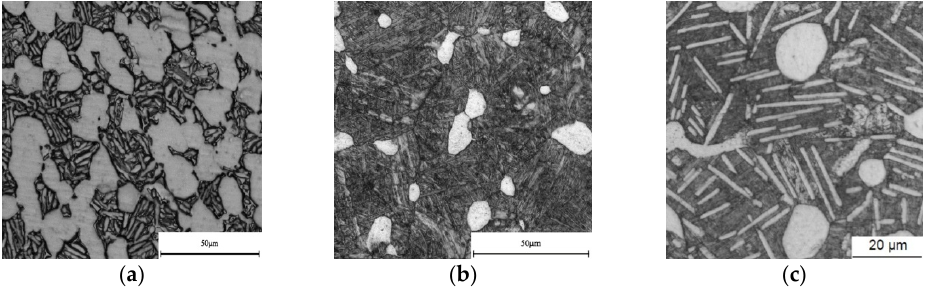
Figure 1. Optical microscopy images of the microstructures prior to heating: ( a ) microstructure I; ( b ) microstructure II; ( c ) microstructure III.